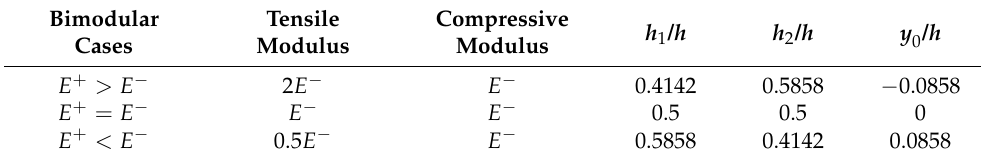
Table 1. Values for three bimodular